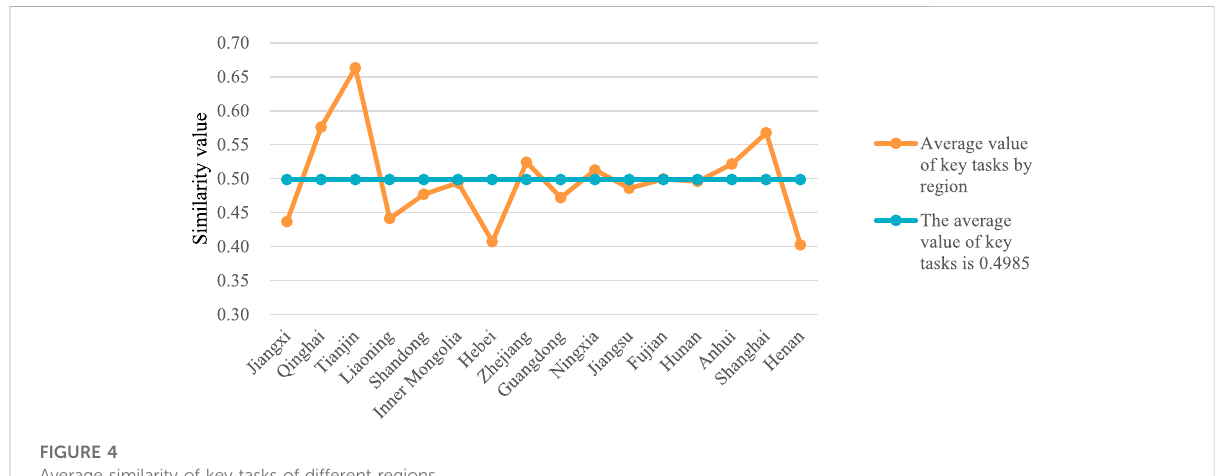
FIGURE 4 Average similarity of key tasks of different regions.